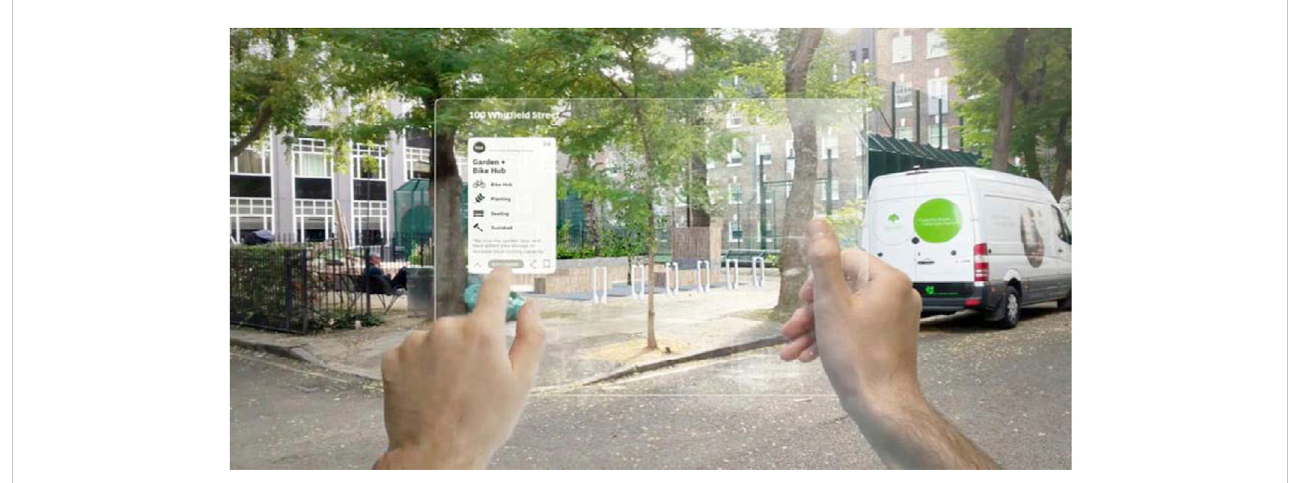
FIGURE 6 The City Planning Prototype made by ARUP / Dan Hill (2018) depicts how users could interact with planning proposals on site through AR. Reproduced withpermissionfromHill,Dan, “ AugmentedPlanningNotice ” Dec13,2022,YoutubeVideo,1:00.Url:https://www.youtube.com/watch?v=zrJkUht9ywI&ab_ channel=DanHill.